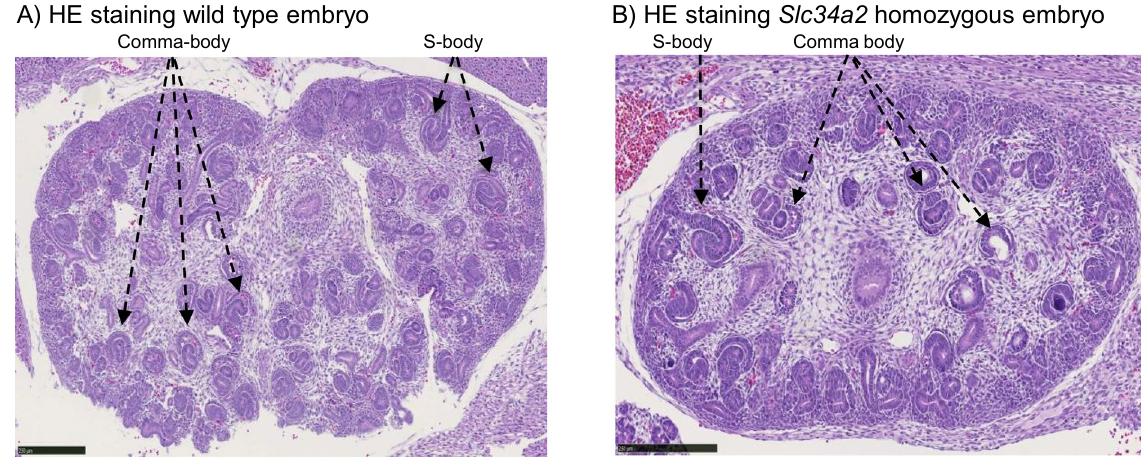
Figure 9. Kidneys from ( A ) wild type and ( B ) Slc34a2 homozygous E18 embryos stained with H&E. Scale bars: 250